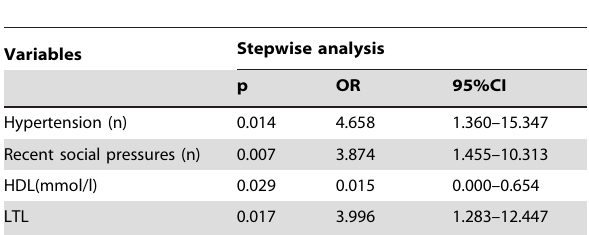
Table 4. Best model for association of cardiovascular risk factors and LTL to stroke in a step wise multivariable model including all significiant risk factors from univariable analyses between stroke and sibling